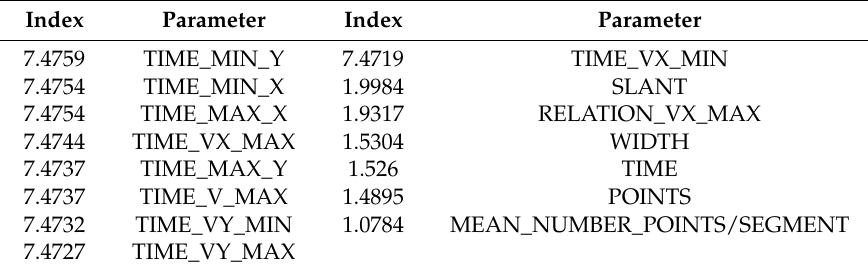
Table 16. Raked parameters using Info Gain Attribute Select for IAM Online Handwriting DB.